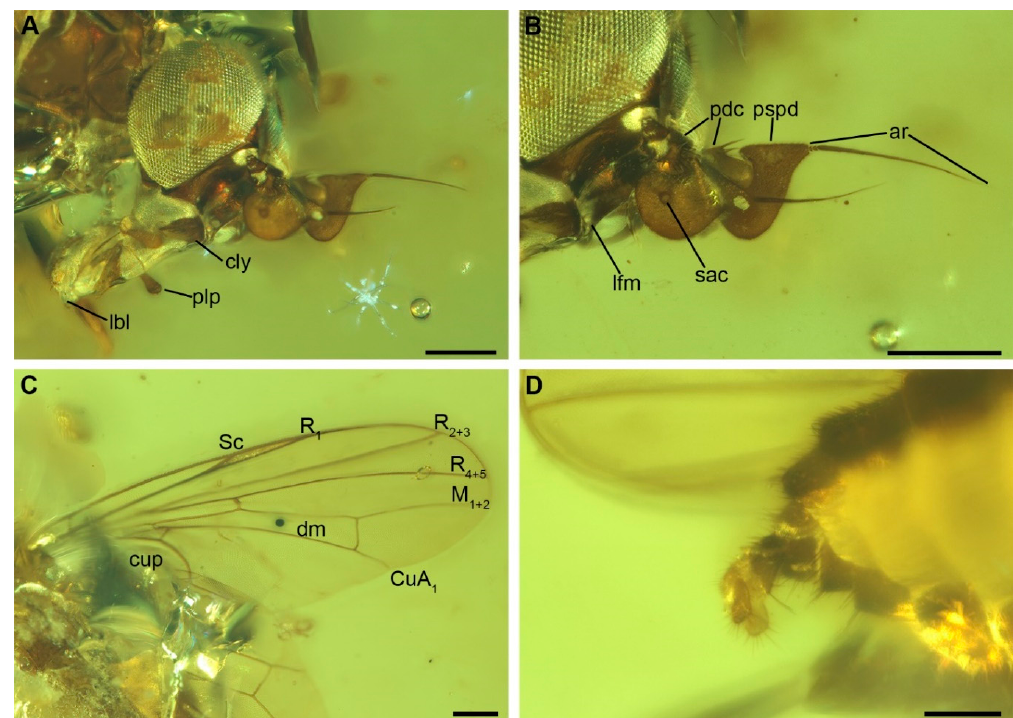
Figure 2. Lebambromyia sacculifera sp. nov., holotype, BA02-14122. ( A ) detail of the head and mouthparts, lateral view; ( B ) detail of the front and antennae; ( C ) wing; ( D ) terminalia. Abbreviations: ar, arista; cly, clypeus, lbl, labellum; lfm, lower facial margin; pdc, pedicel; plp, palpus; pspd, postpedicel; sac, sacculus; Sc, Subcosta; R, Radius (and its branches); M, Media; CuA1, Cubitus anterior; dm, discal-medial cell; cup, anal cell. Scale bar: 200 µm.